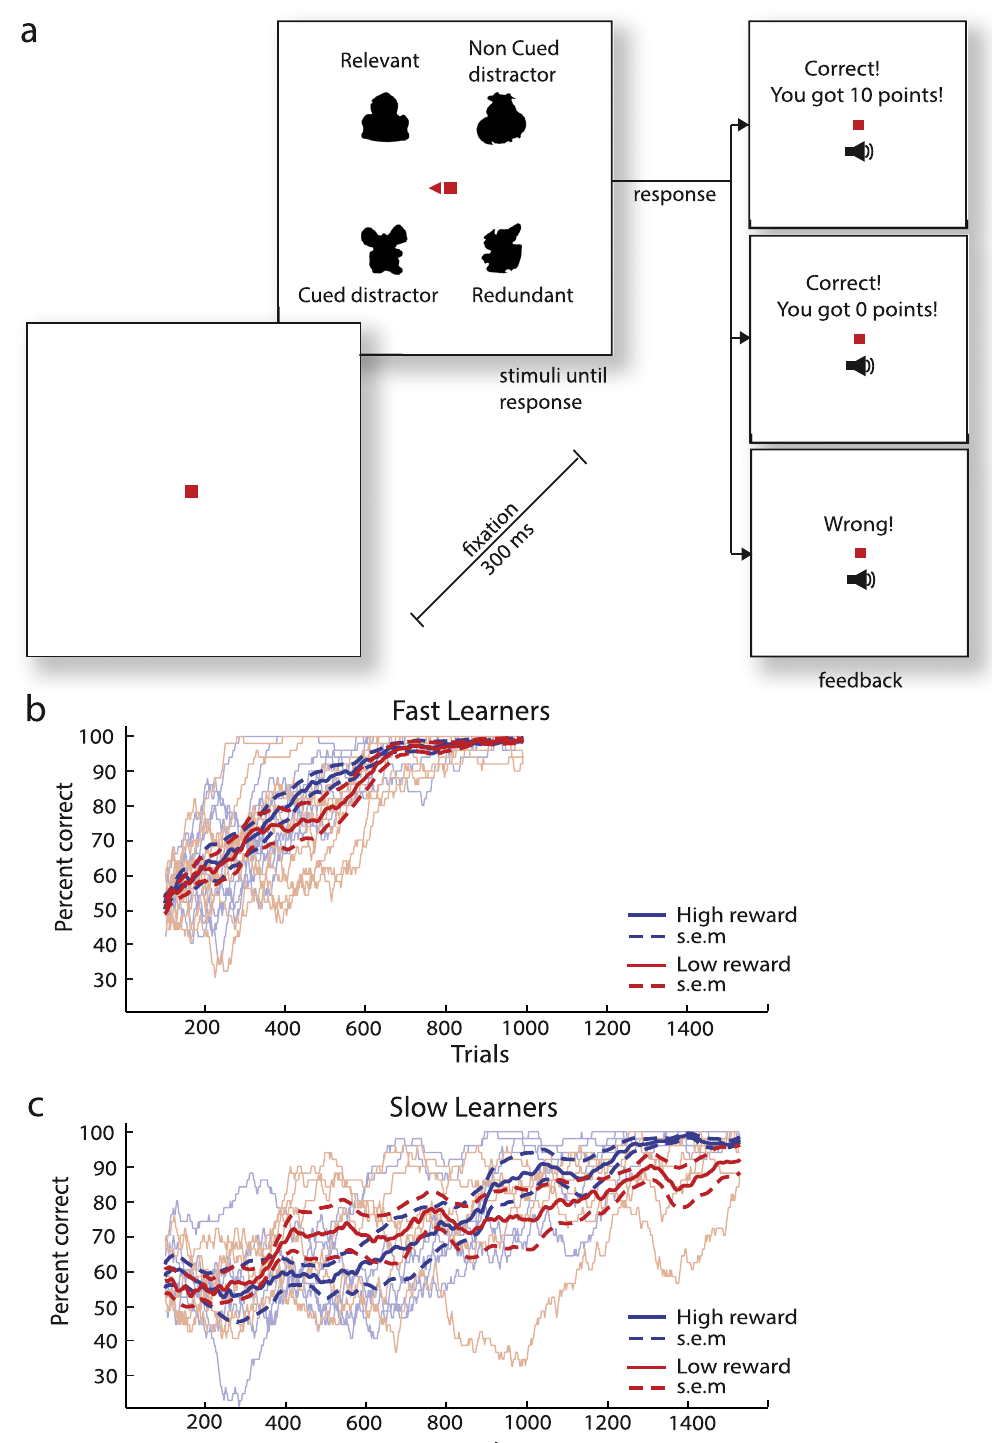
Figure 1. Shape learning task. ( a ) Trial structure. In every trial the participants saw four icons. They were instructed to pay attention to the side of the screen that was cued with a red triangle. Their task was to determine which of the two icons on the cued side was associated with a particular response button, by trial and error. They received auditory and visual feedback whether their response was erroneous or correct and on correct trials they also received feedback about the number of points that they gained (0 or 10 points). ( b ) Accuracy of the subjects that learned fast (within 1024 trials). Blue curves represent the accuracy for the high- reward icons and red curves the accuracy for the low-reward icons. The lighter curves show the accuracies of individual subjects (in a window of 50 trials) and the darker curves the average across subjects (N = 10 fast learners). Dashed lines represent s.e.m. ( c ) Accuracy of the 6 subjects that learned more slowly and received additional